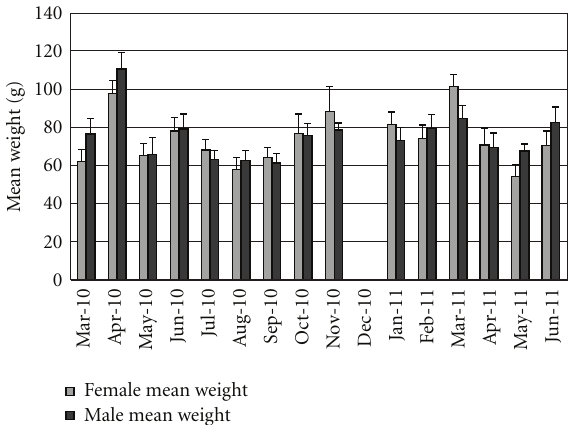
Figure 2: Mean length ( ± S.D.) of female and male Mya arenaria sampled at Bannow Bay from March 2010 to June 2011.